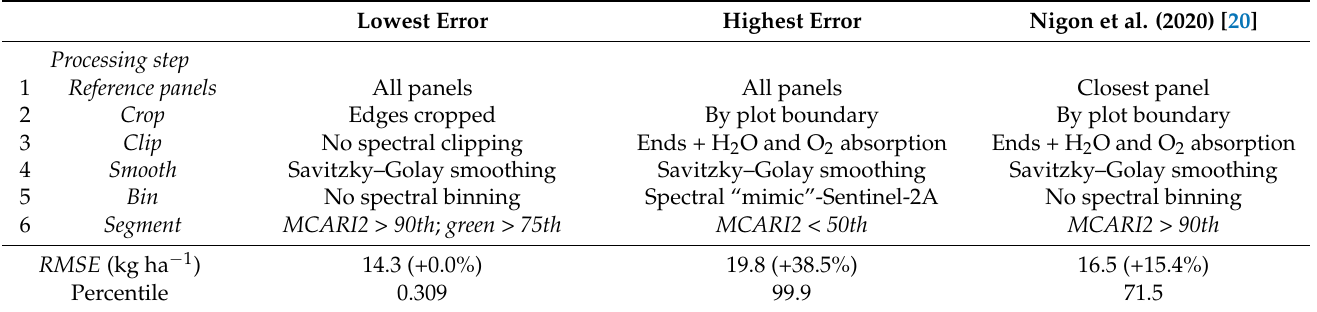
Table 4. The image processing workflow with the lowest and highest root mean squared error ( RMSE ), as well as the processing workflow chosen by Nigon et al. (2020). The error, the percent increase in error compared to the workflow with the lowest error, and the corresponding percentile across all unique scenarios evaluated in this study are listed for each of the three